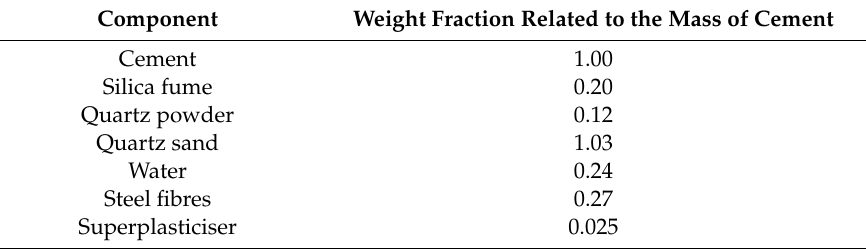
Table 2. RPC mixture